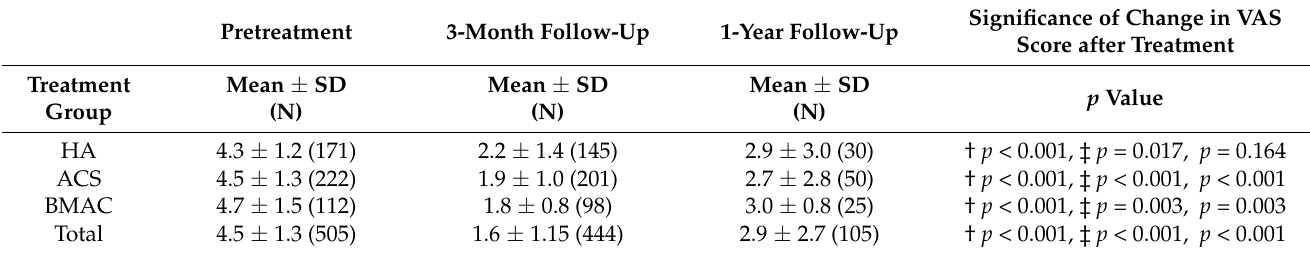
Significance of Change in VAS Score after Treatment